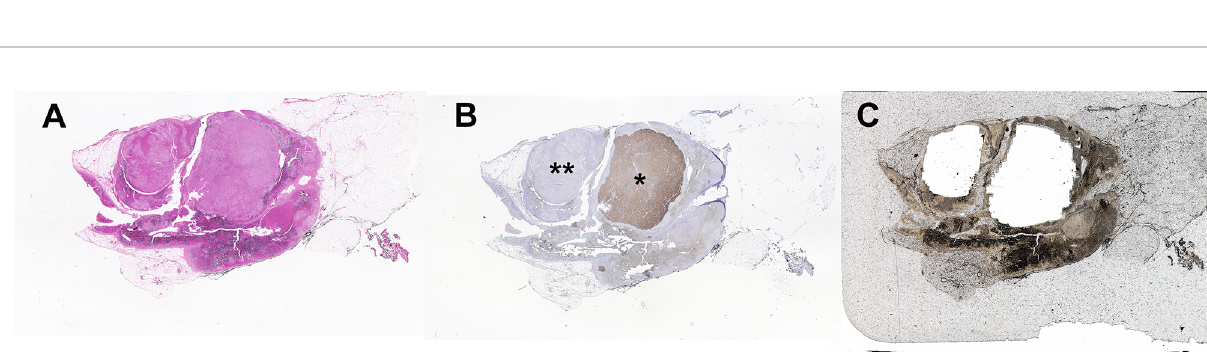
FIGURE 1 | Proposed method for DNA mutation analysis using excised adrenal tissue sections from patients with primary aldosteronism. This approach uses CYP11B2 immunohistochemistry (IHC) to de fi ne the source of aldosterone for DNA capture in FFPE tissue sections. Captured DNA is then used for Sanger or gene- targeted deep sequencing to detect known and/or novel drivers of aldosterone production.